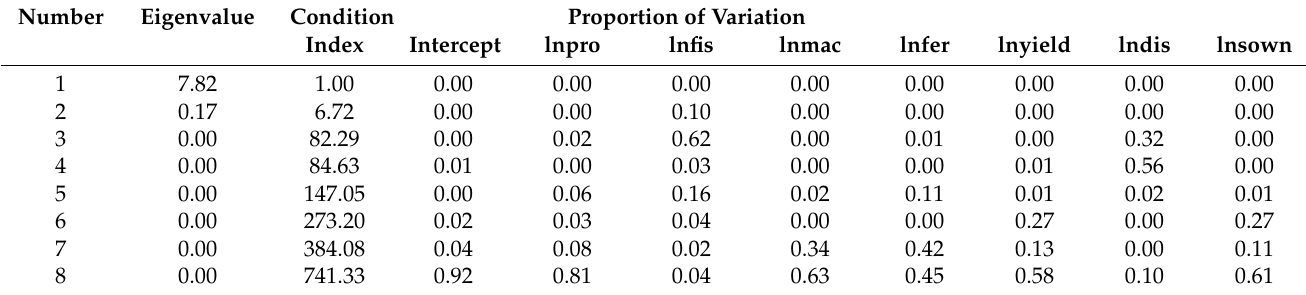
Table 4. Collinearity